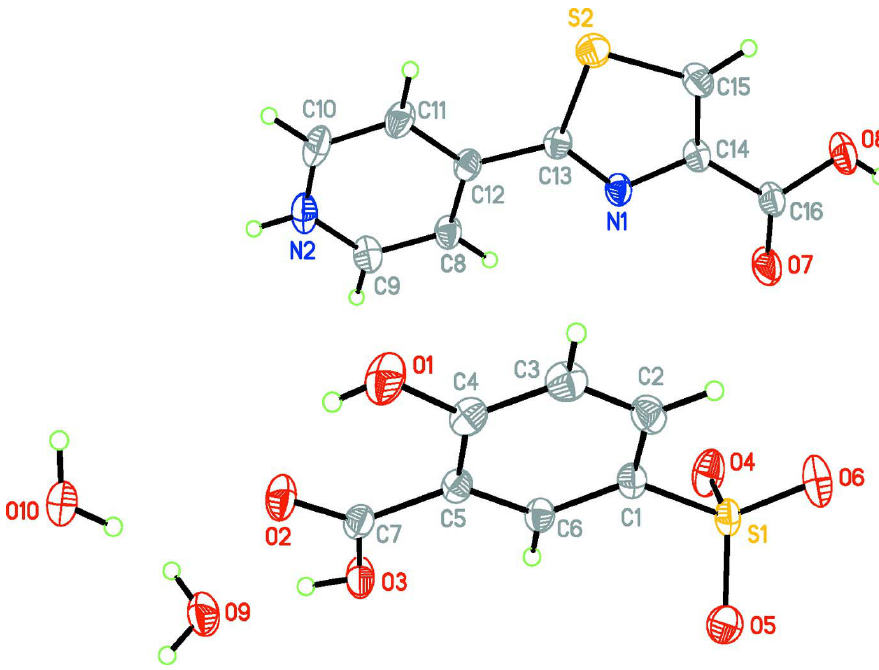
Figure 1 Molecular structure of (I), with displacement ellipsoids drawn at the 30% probability level.